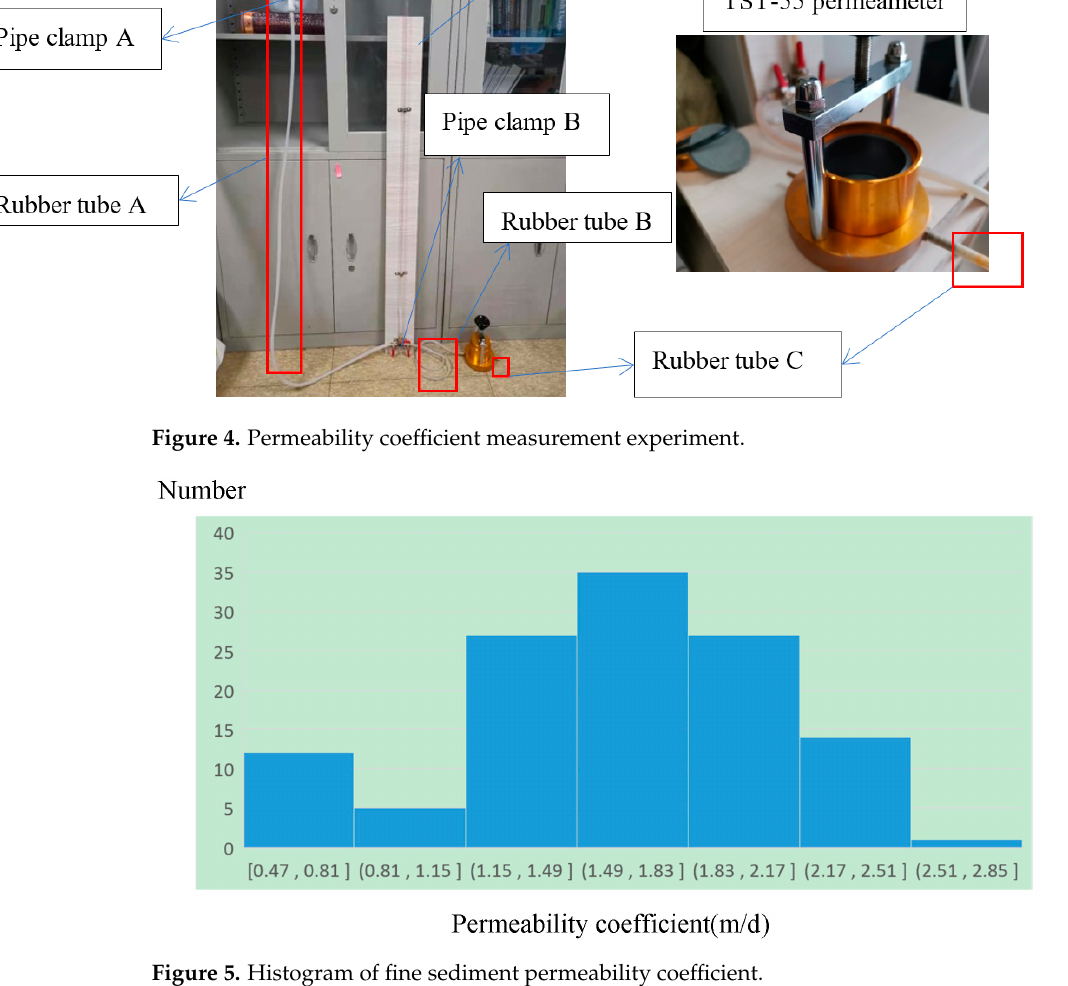
Figure 4. Permeability coefficient measurement experiment.